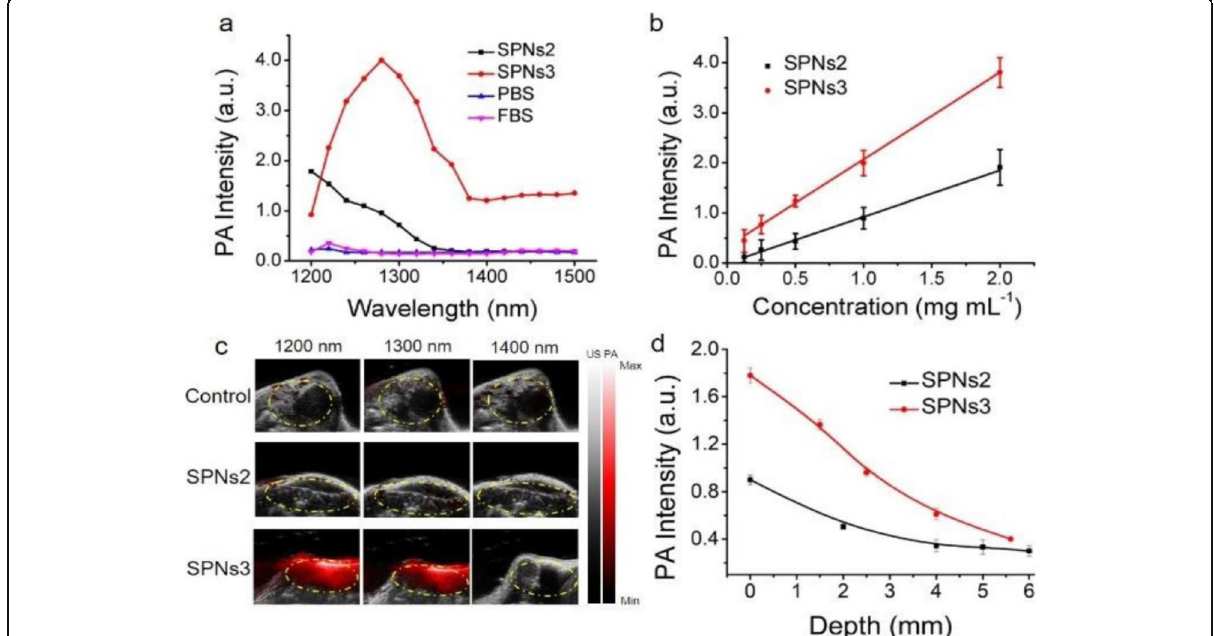
Fig. 4 a PA spectra of 2 mg/mL SPNs2 – 3, PBS, and FBS; b PA signal of SPNs2 – 3 at various concentrations; c PA/US co-registered images without injection of SPNs2 – 3 (control) and with intratumoral injection of 50 μ L, 500 μ g/mL SPNs2 – 3 (dashed circles); d Fitted PA signal curves of SPNs2 – 3 solutions (1 mg/mL) at various depths in chicken breast tissue